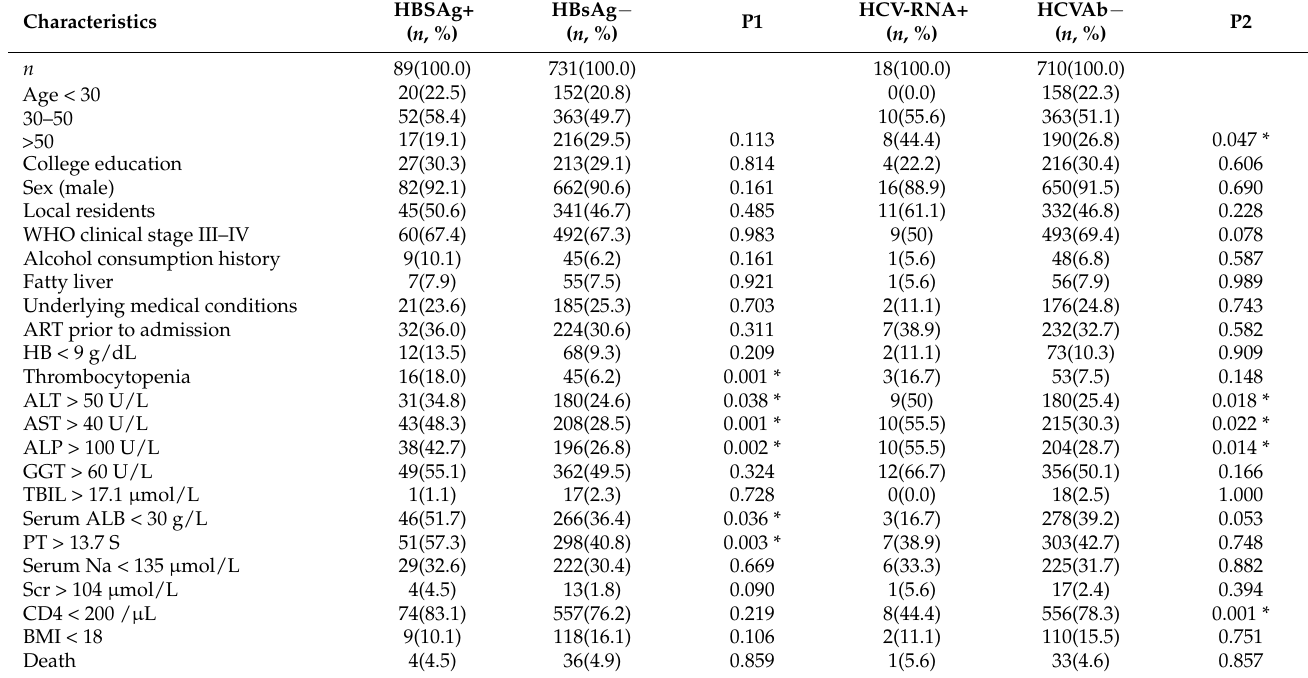
Table 2. The baseline clinical features of HBV/HIV- or HCV/HIV-coinfected